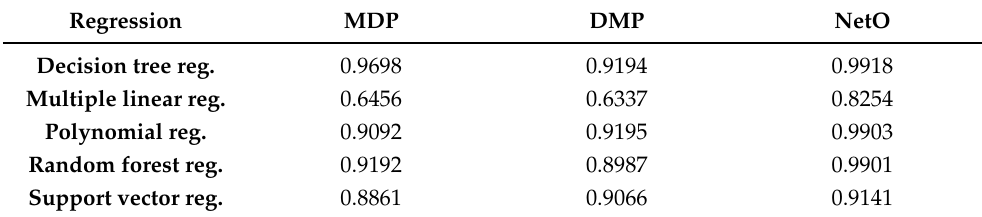
Table 4. Evaluating the models